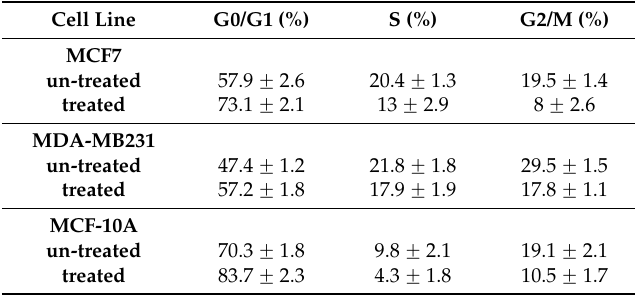
Table 3. Cell cycle evaluation. We show the cell percentages in G0/G1, S and G2/M phases for MCF7 and MDA-MB231 cells before and after treatment with 63 µ g/mL and 64.5 µ g/mL of phenolic extract from FS oil, respectively, and MCF10A with 64.5 µ